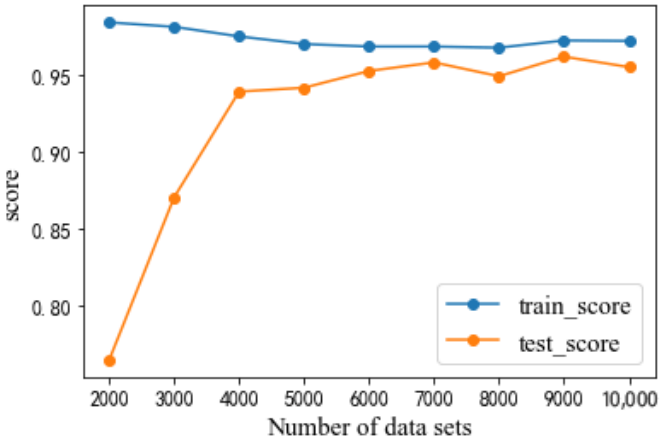
Figure 11. MLP model performance for different numbers of data sets.